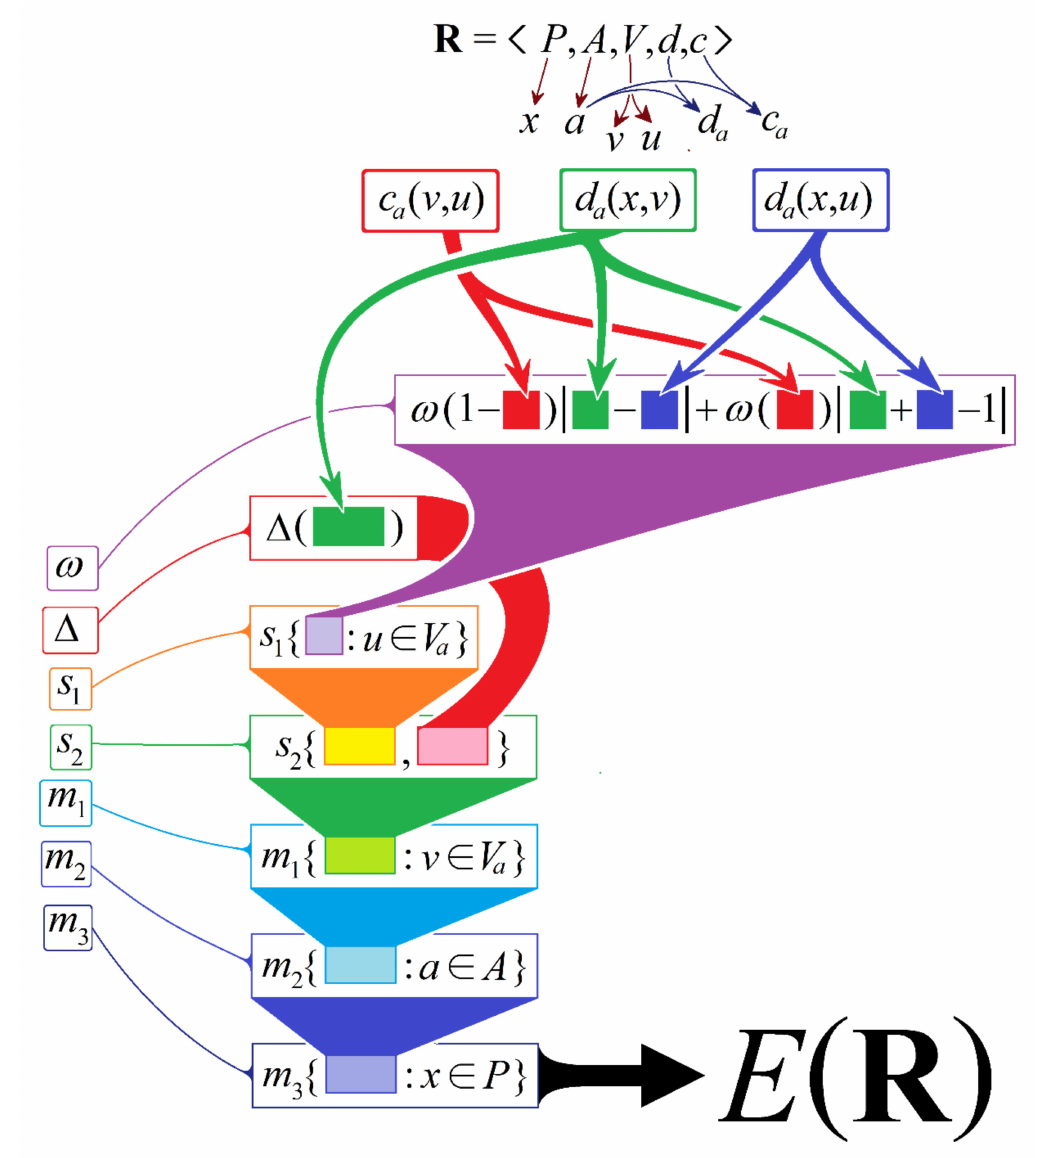
Figure 1. The entire workflow of determining the entropy measure R of a plithogenic